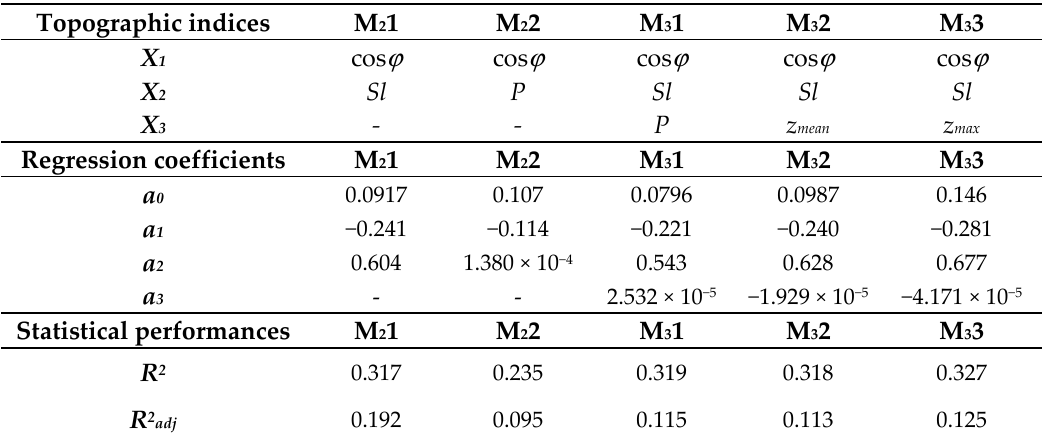
Table 6. Regression coefficients, coefficient of determination, R 2 , and adjusted coefficient of determination, R 2adj for five selected multiple regression models.